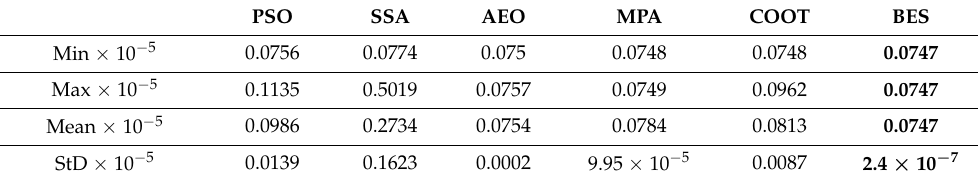
Table 8. Identification statistics for test 2 for Banner battery case.